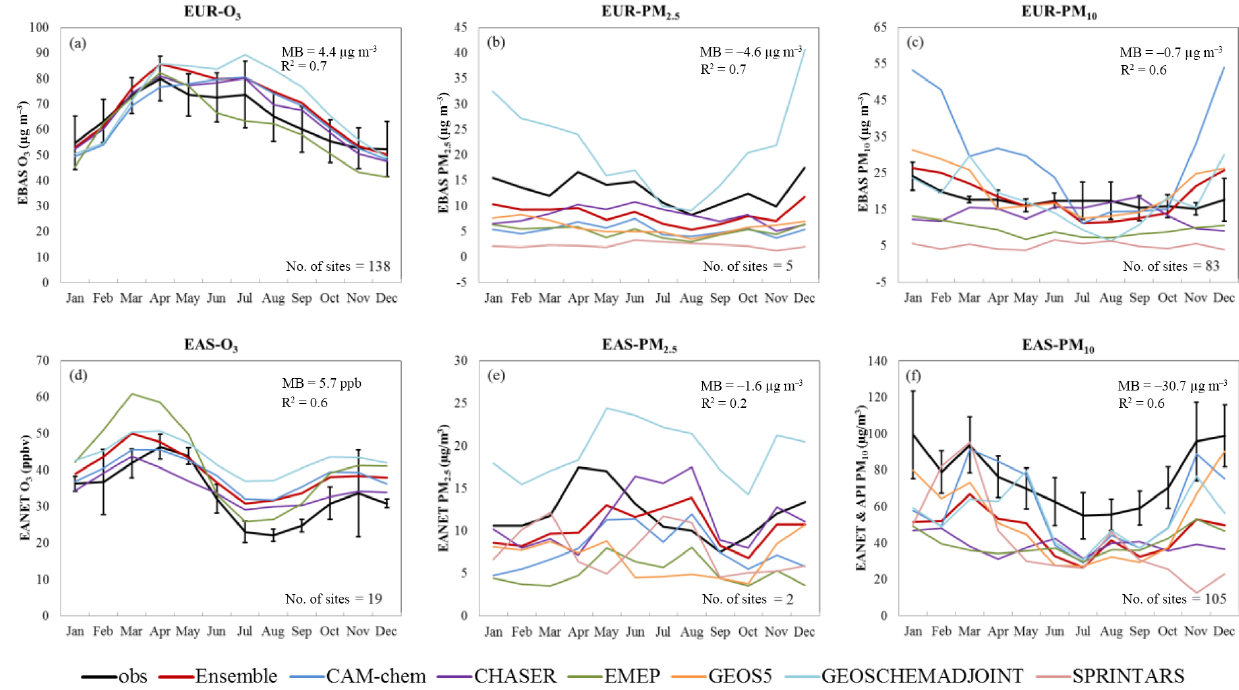
Figure 2. Monthly mean surface concentrations of O 3 (a, d) , PM 2 . 5 (b, c) , and PM 10 (c, f) for the year 2010 in the EUR (a, b, c) and EAS (d, e, f) regions from observations and model simulations. Observations (bold black lines with vertical error bars) represent the averages of all sites falling within the same ensemble grid (bold red lines), and the vertical error bars depict the standard deviation across the sites in the same ensemble grid. Models are sampled at the nearest grid to each station; multiple stations within the same model grid are averaged to represent the paring